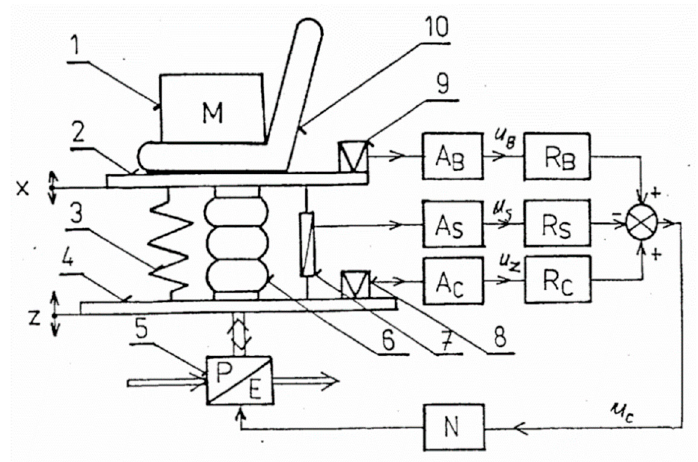
Figure 4. Active seating system vibration controls with a parallel spring structure [51].